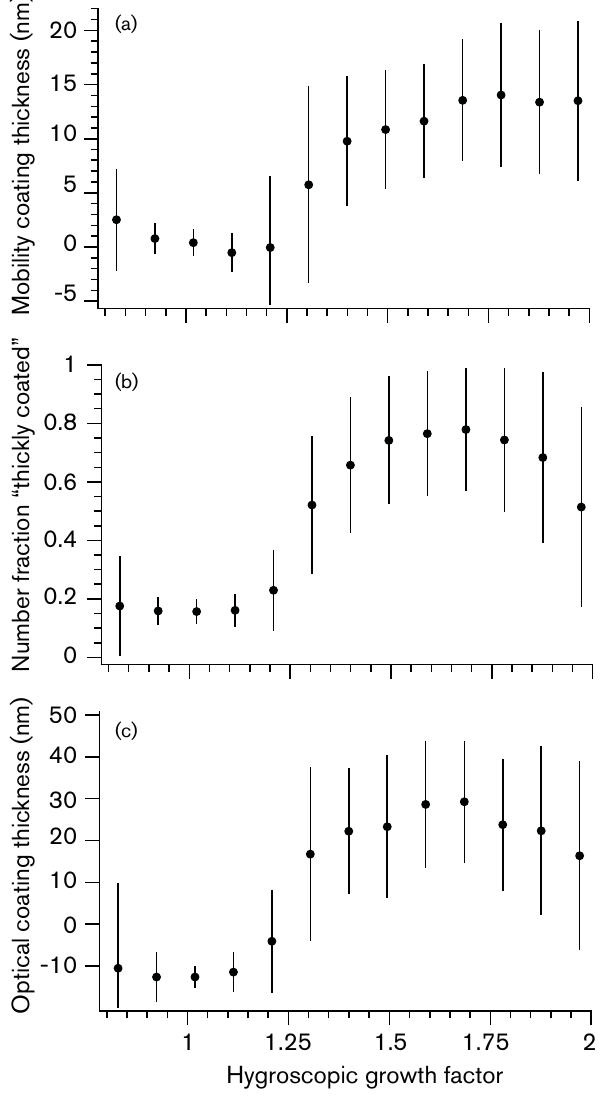
Fig. 8. SP2-derived coating information for HTDMA-SP2 scans for ambient Manchester rBC between 11–16 August 2010. Shown are the mean and standard deviations binned by growth factor for mobility-derived coating thickness (a) , number fraction of thickly coated rBC particles (b) , and optically derived coating thickness (c)